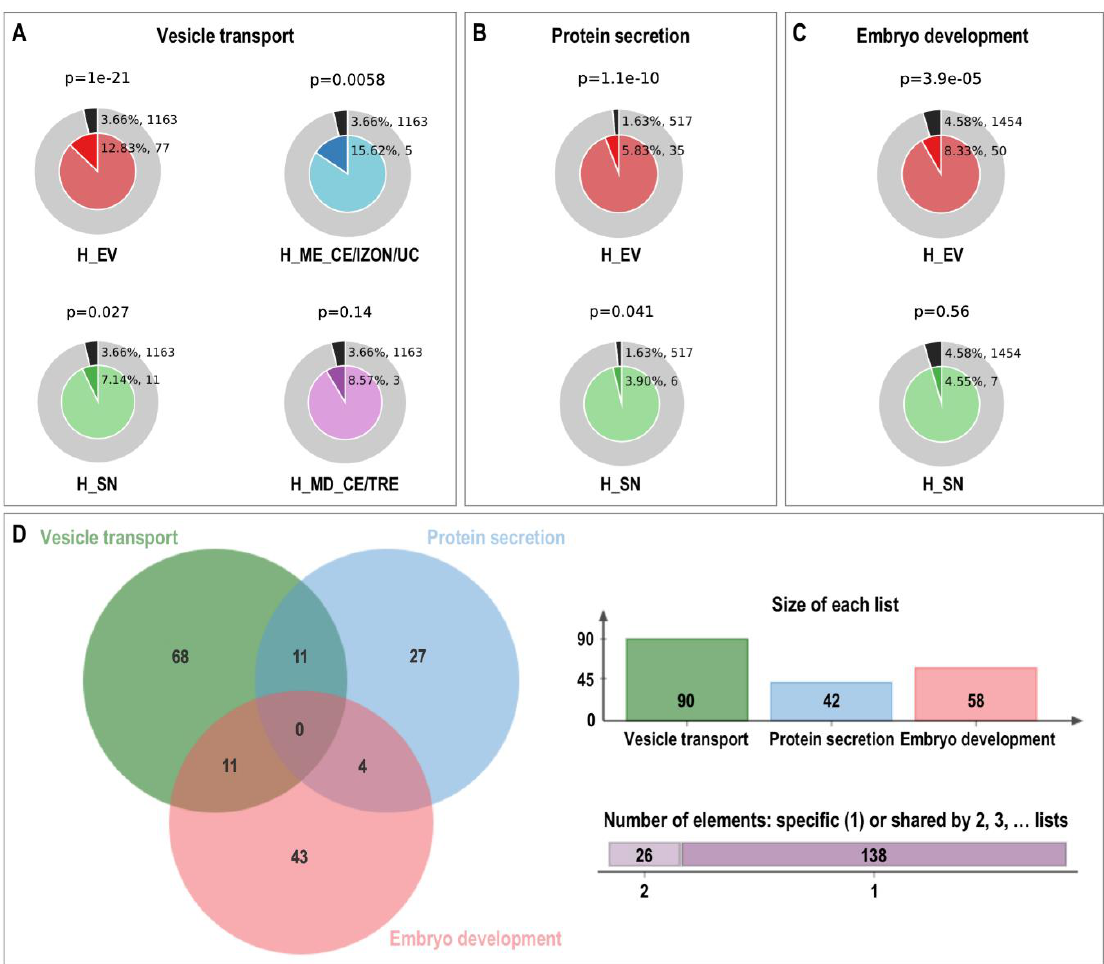
Figure 7. Functional membership analysis for proteins identified by Mass Spectrometry for specific terms using Metascape tool. Enrichment of proteins matching membership terms: ( A ) “vesicle transport”, ( B ) “protein secretion” and ( C ) “embryo development”. The outer pie shows the number and the percentage of proteins in the background that are associated with the membership (in black); the inner pies shows the number and the percentage of proteins in the individual input gene list that are associated with the membership. The p -value on the top of the pie charts indicates whether the membership is statistically significantly enriched in the list. H_EV: proteins highly enriched in EVs obtained by all methods; H_SN: proteins highly enriched in supernatant (SN); H_MD_CE/TRE proteins highly abundant in MD_CE/TRE; H_ME_CE/IZON/UC: proteins highly abundant in ME_CE/IZON/UC. ( D ) The Venn diagram illustrates the total number of proteins found for each membership term using the Metascape tool and the number of protein common or exclusive for each term.